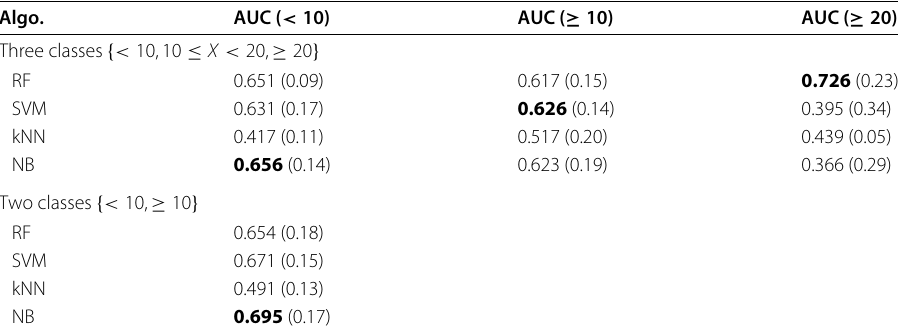
Table 5 Heat pump age in years with data from week 10, 2020 using smart meter and weather